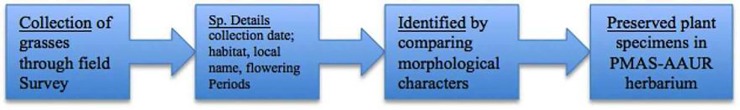
Different steps in the collection and identification of grasses.